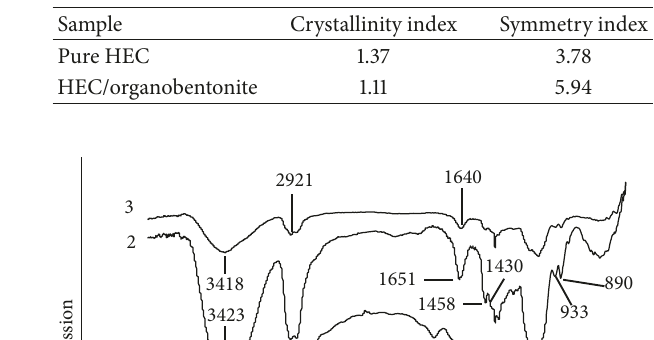
Table 5: Infrared crystallinity and symmetry indexes for pure HEC and HEC/organobentonite composites.